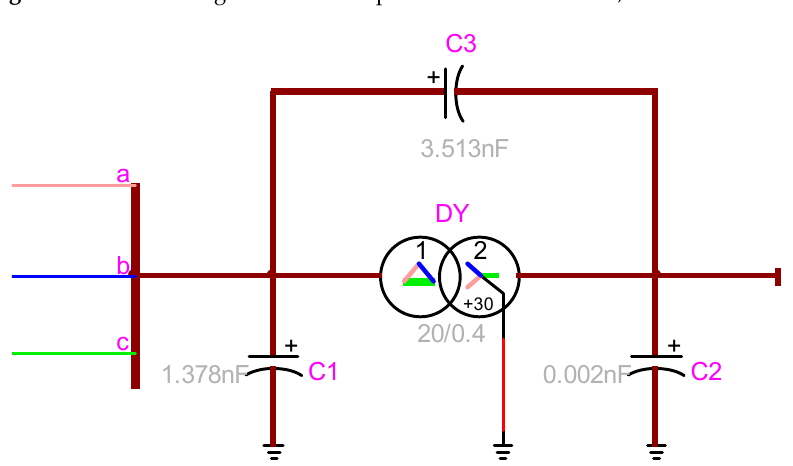
Figure 5. ∆Y connection model of the transformer with measured capacitances.